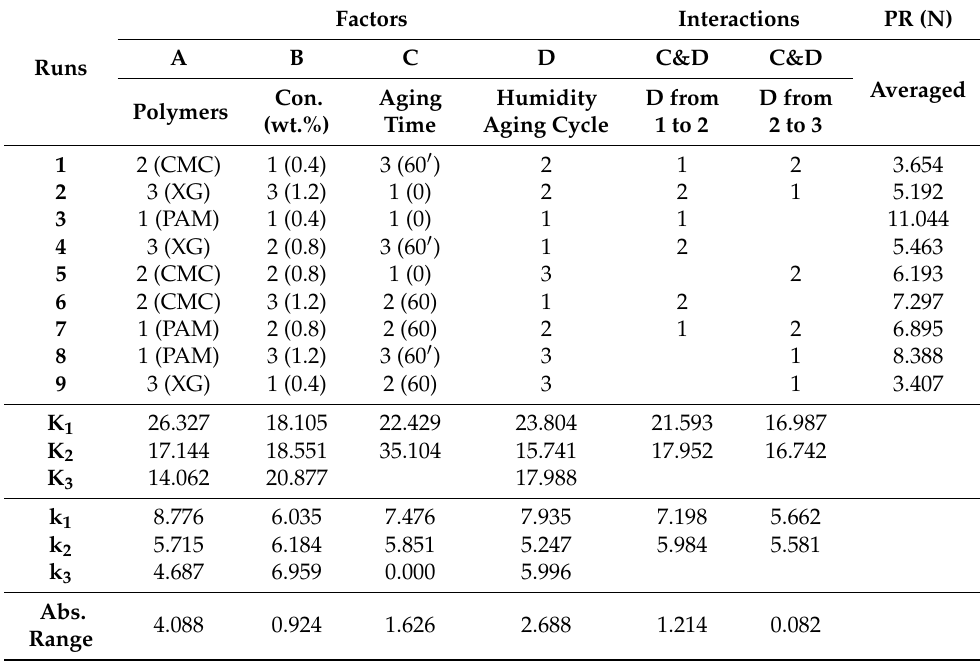
Table 5. Results of humidity aging test for individual polymer application.